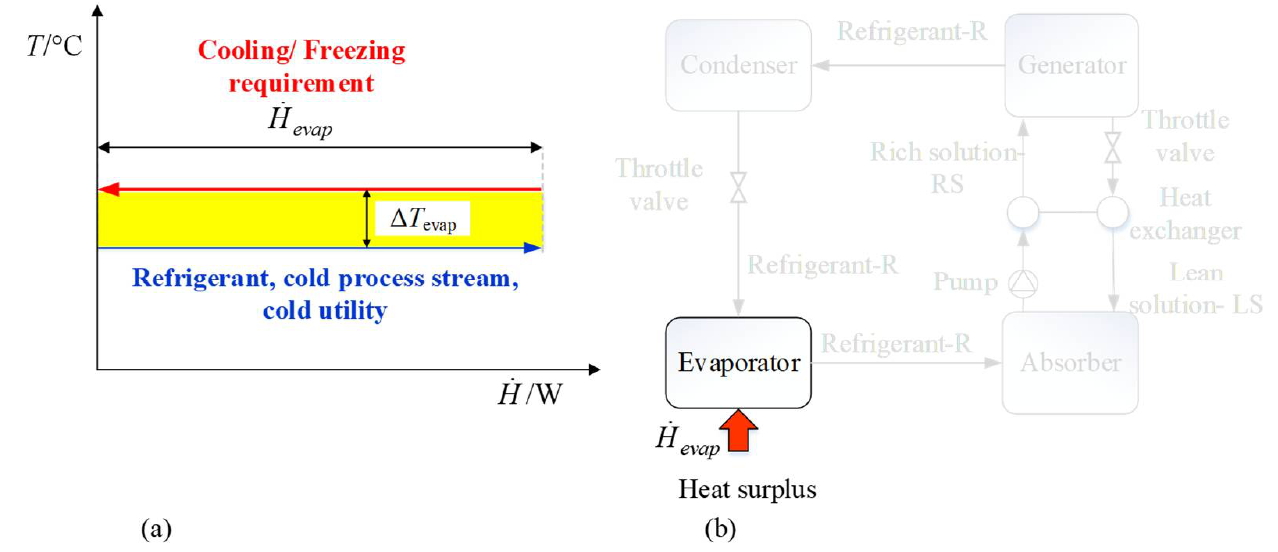
Figure 2. ( a ) Heat integration of cooling represented by the composite curve of the evaporator and ( b ) presentation of evaporator as a part of AC cycle.